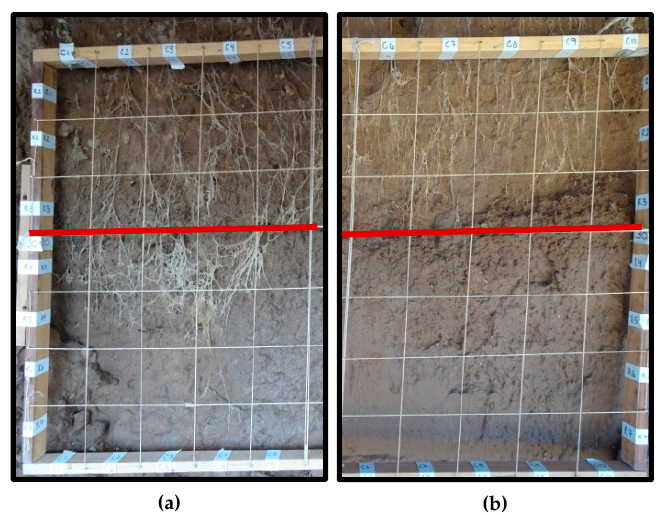
Figure 4. Roots of physiologically mature barley varieties at 90–100 cm depth when grown under low irrigation in 2018: ( a ) “Solar” roots; ( b ) “Kopious” roots.